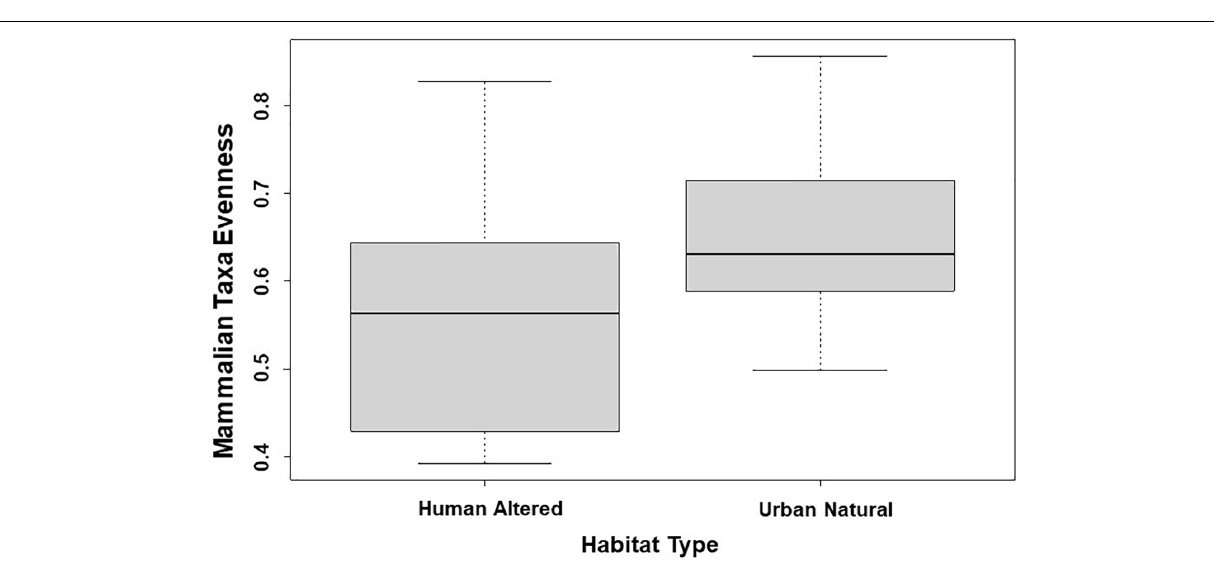
the amount of available habitat (Arrhenius, 1921; Turner et al., 2005). In the case of the current study, we find evidence of the species-area effect in an urban